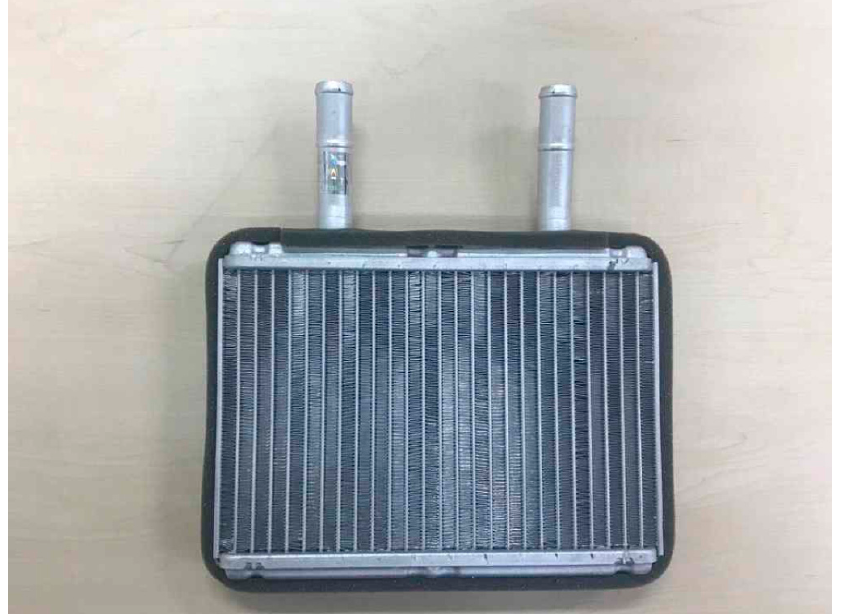
Figure 5. Indirect type heater core.